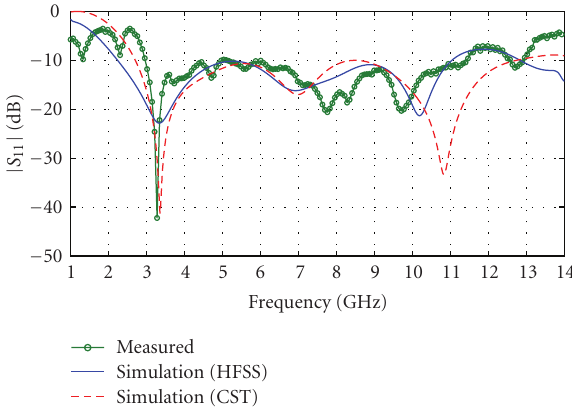
Figure 2: Measured and simulated | S 11 | for the UWB antenna ele- ment with a microstrip line feed.